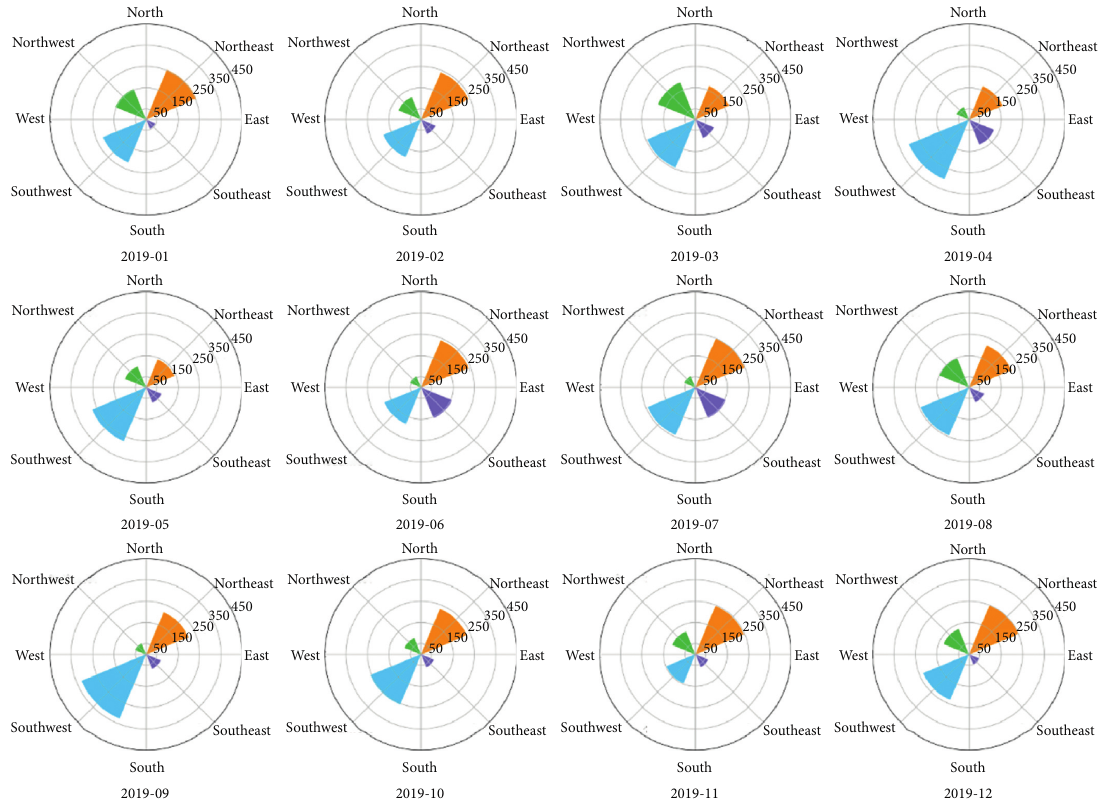
Figure 8: Comparison of the number of hours with different wind directions in the months of